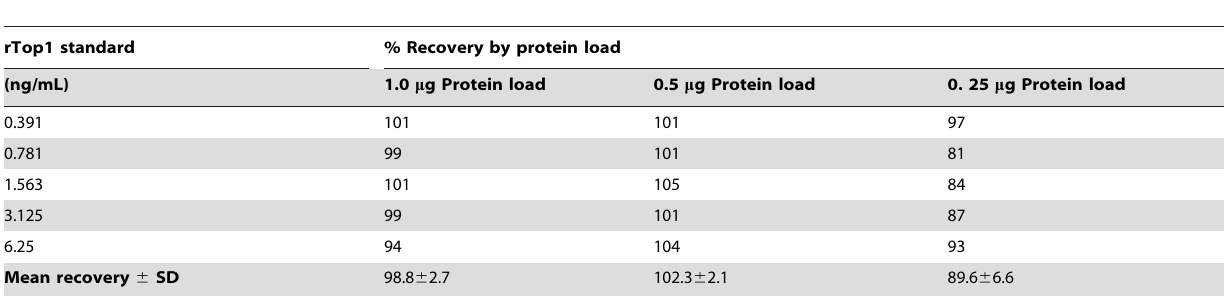
Table 1. Percent recovery of rTop1 standards spiked into A375 xenograft extracts at three different protein loads.